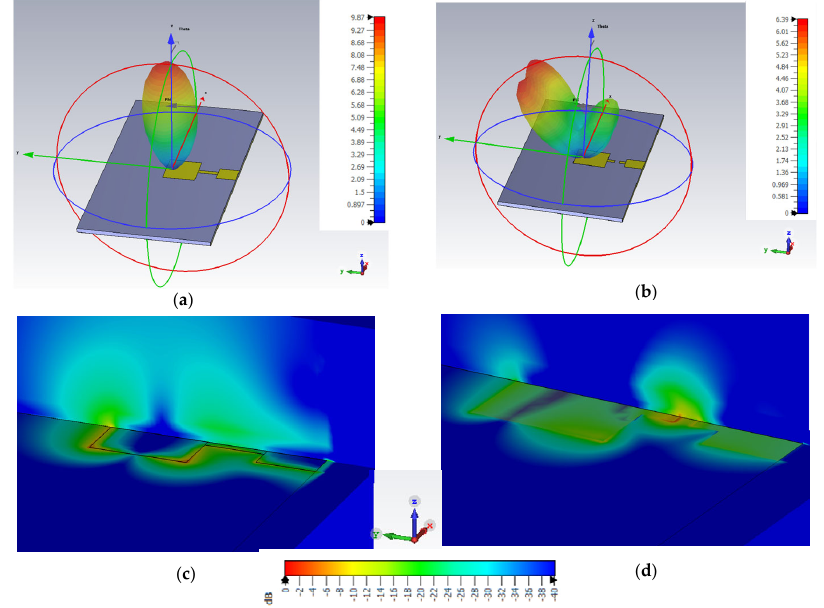
Figure 4. The 3-D linear radiation pattern for ( a ) healthy and ( b ) damaged antenna and electric field distributions of the ( c ) healthy and ( d ) damaged patch antenna.